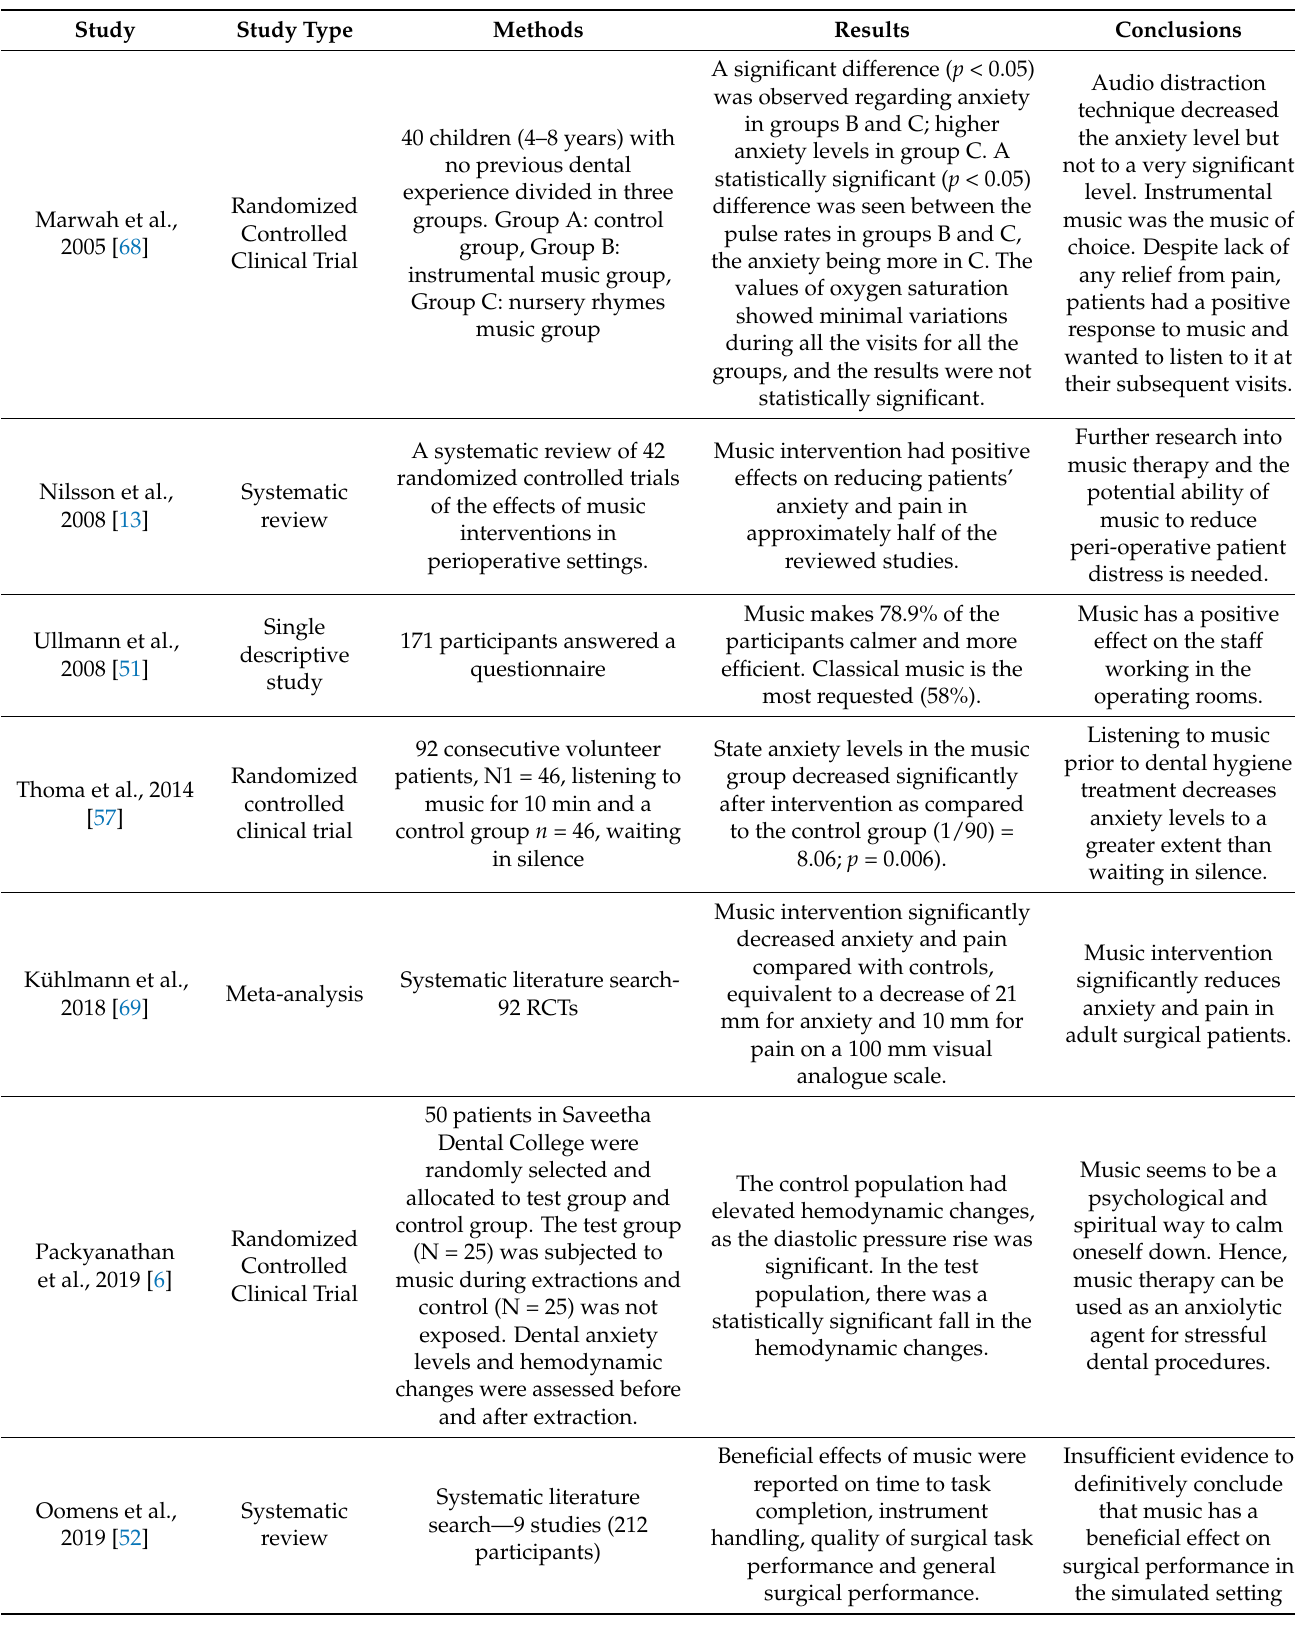
Table 1. Selected literature on sound effects in dental